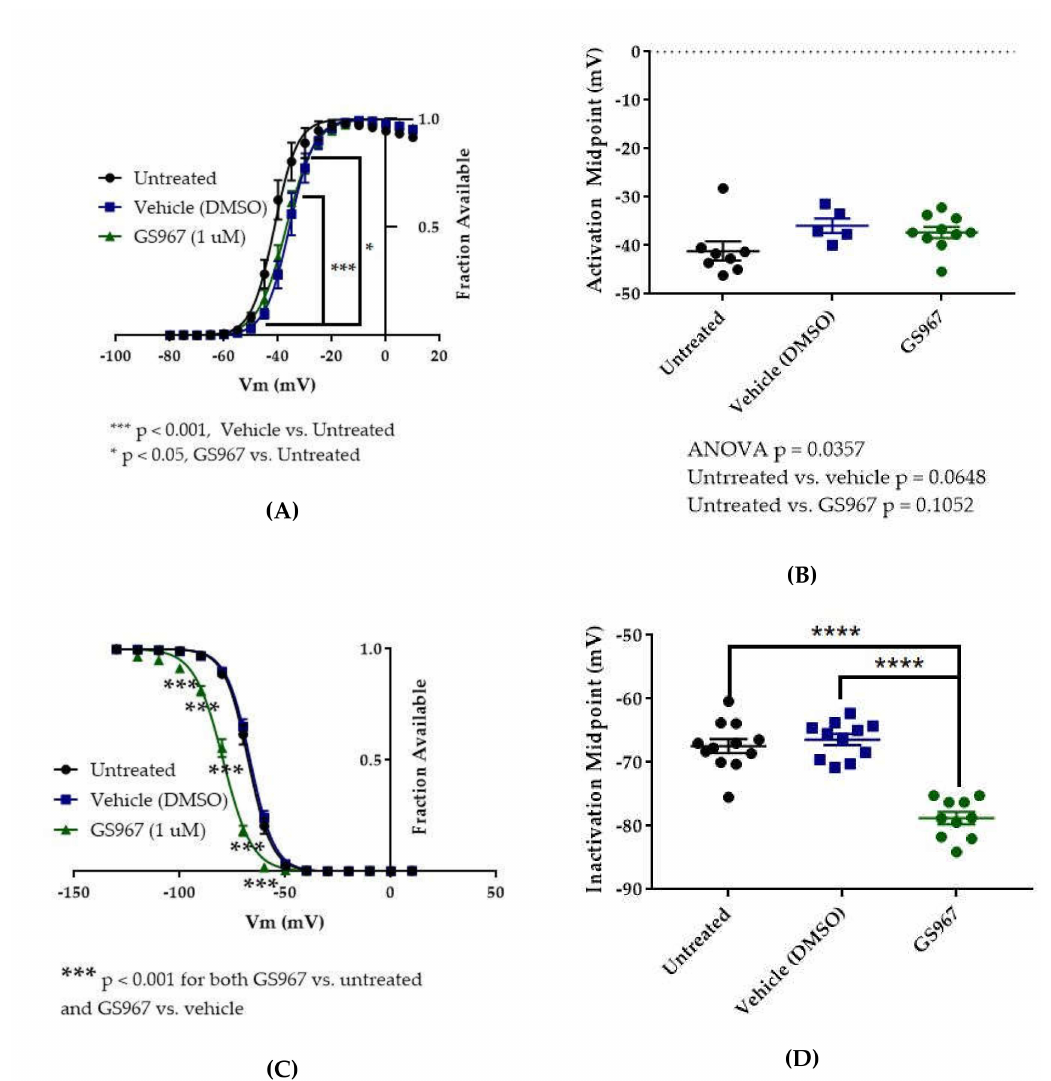
Figure 8. E ff ects of GS967 on WT hNav1.2 gating in stable HEK cell lines. ( A ) Activation